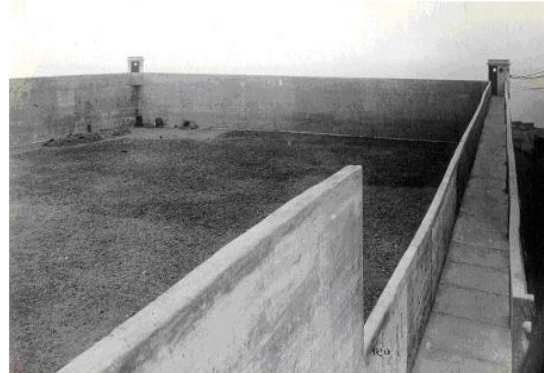
Figure 14. Recreation Yard Walls